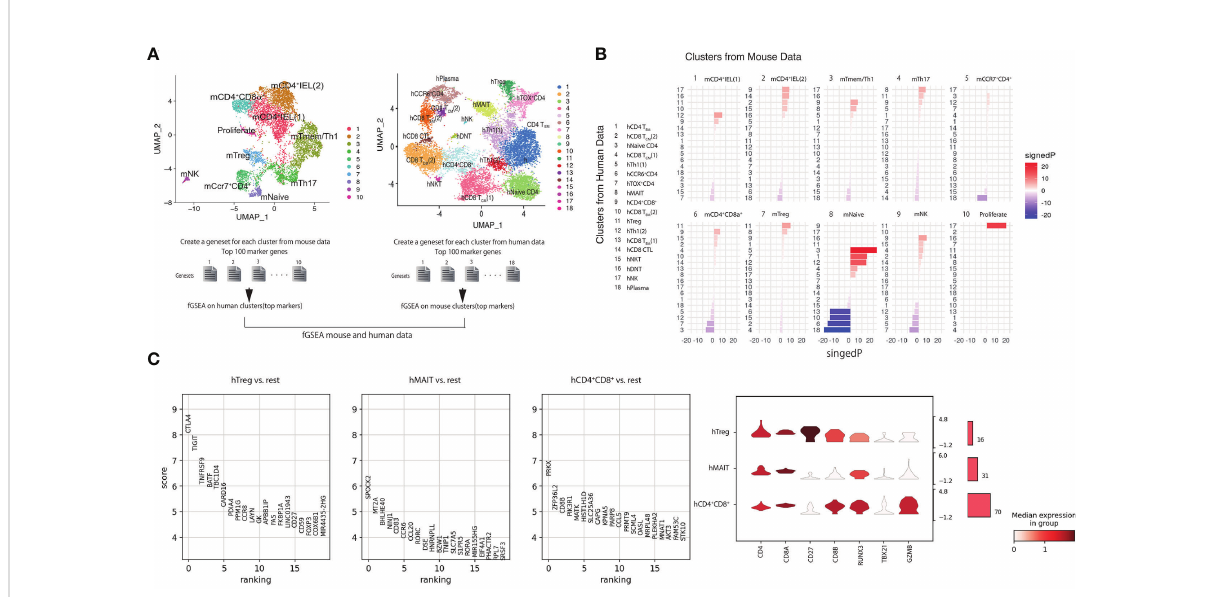
FIGURE 5 Cells in hCD4 + CD8A + cluster are similar to mCD4-CTLs by using fGSEA (A) Schema of the integrated mouse single-cell RNA-seq data with the human single-cell RNA-seq data using fGSEA. (B) Enrichment of mouse cluster gene sets within each human gene cluster via gene set enrichment analysis. (C) Top 20 genes in CD4 + CD8A + T cells expressed in hTreg, hMAIT, and hCD4 + CD8A + clusters compared with other cell populations. (D) Expression of CD4, CD8A, CD27, CD8B, RUNX3, TBX21, and GZMB in CD4 + CD8A + T cells in hTreg, hMAIT, and hCD4 + CD8A +